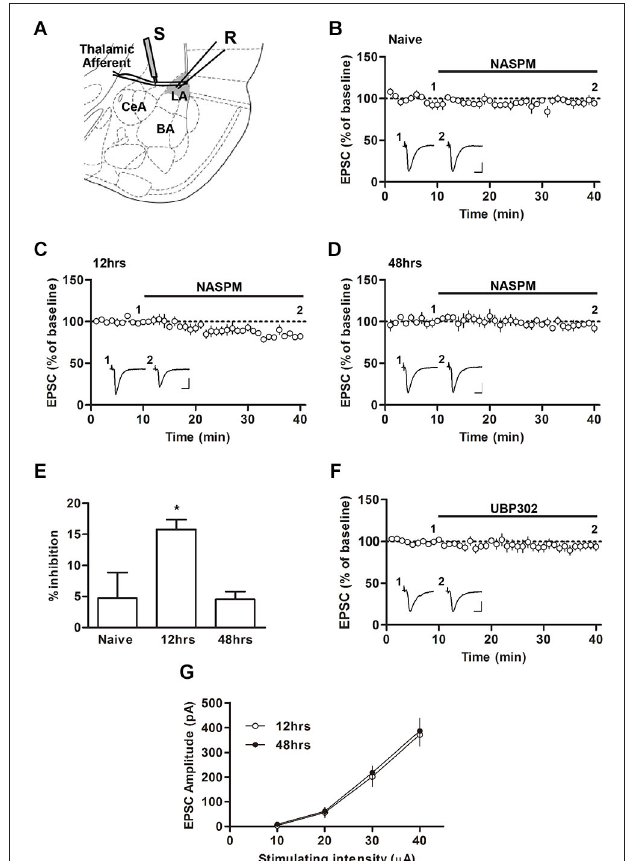
FIGURE 1 | Changes in the sensitivity to NASPM after fear conditioning . (A) Diagram showing the positions of the stimulating and recording electrode. BA, basal nucleus of amygdala; CeA, central nucleus of amygdala; LA, lateral nucleus of amygdale; R, recording electrode; S, stimulating electrode. (B–E) NASPM (50 µ M) treatment reduced the EPSC amplitude in the presence of D-AP5 (50 µ M) in slices prepared 12 h after conditioning but not 48 h after conditioning or from naïve rats. (F) UBP302 treatment displayed no significant effects on the EPSC amplitude in slices prepared 12 h after conditioning. (G) The input-output relationship was not different between the groups of slices prepared 12 and 48 h after conditioning. * p < 0.05. Scale bars: 50 pA and 10